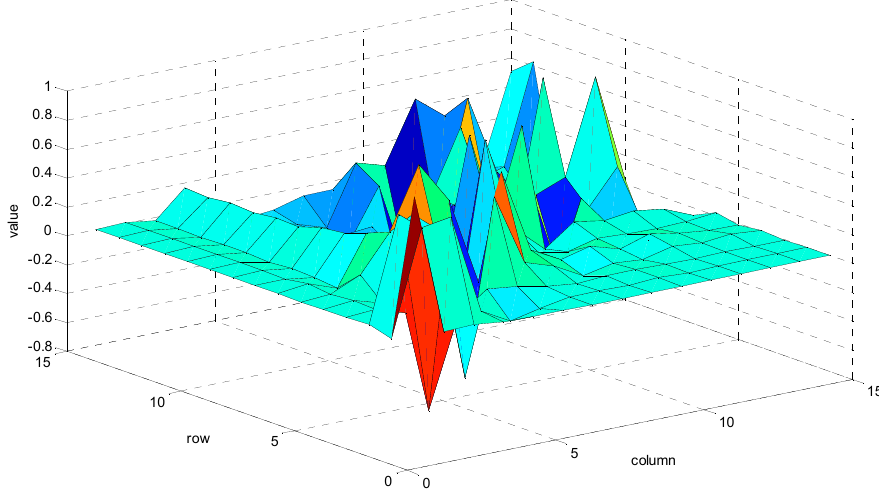
Figure 10. An example rotation matrix (“value” means the average value of cells in rotation matrices, “column” means the column of rotation matrix, and “row” means the row of rotation matrix).